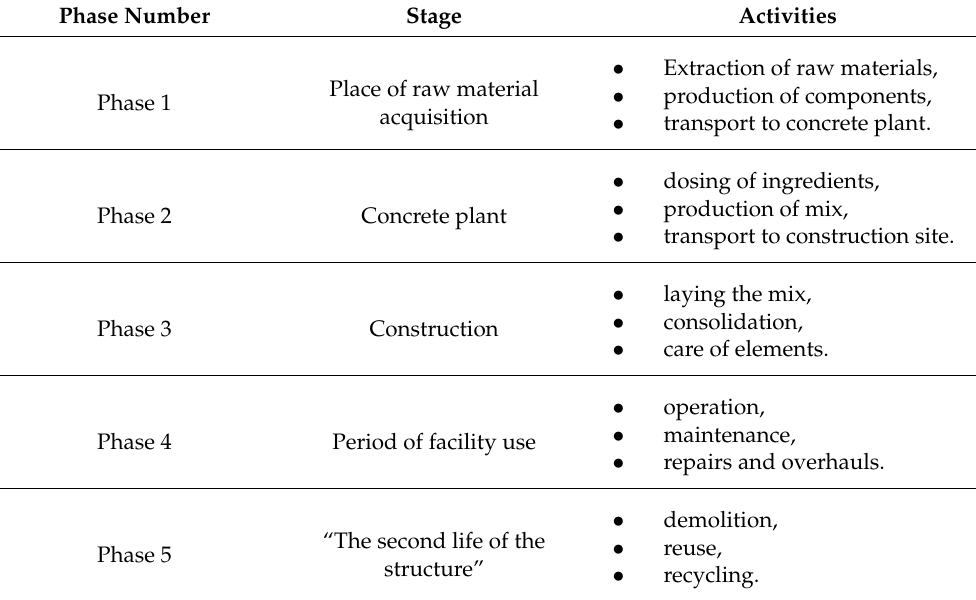
Table 2. Implementation phases in a complete cycle of a typical concrete structure